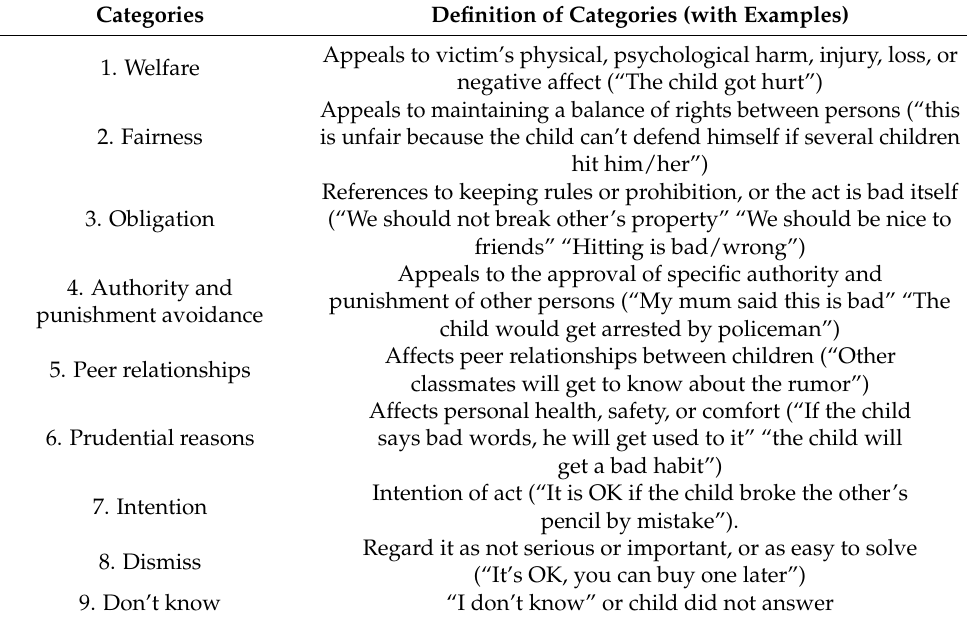
Table 1. Categories for reason for judgment (Why do you think that?).